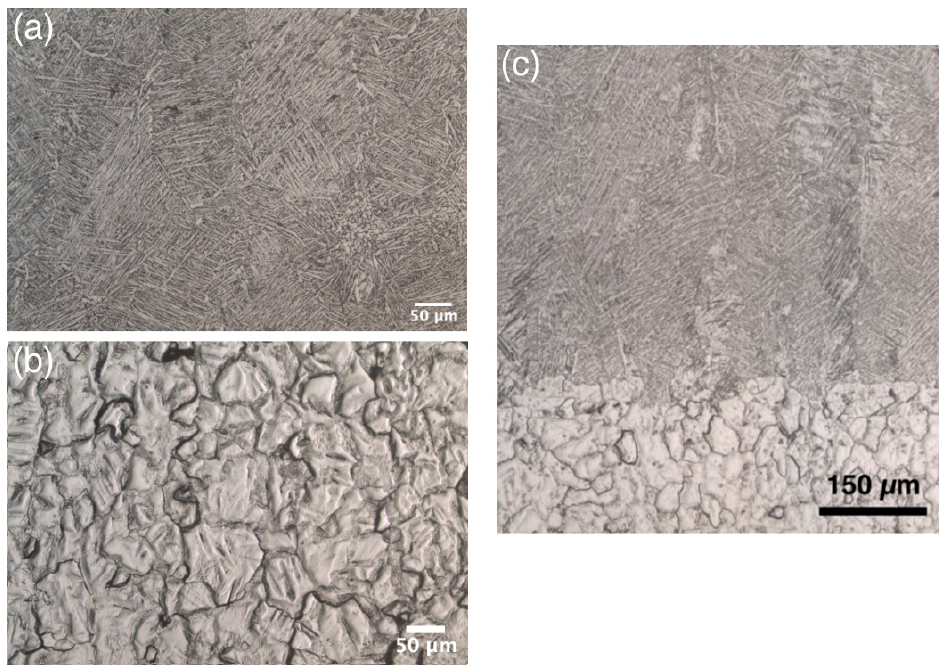
Figure 6. Microstructures of Ti/Ti64 sample after HIP: ( a ) Ti64 zone, ( b ) Ti zone, and ( c ) the transition zone.